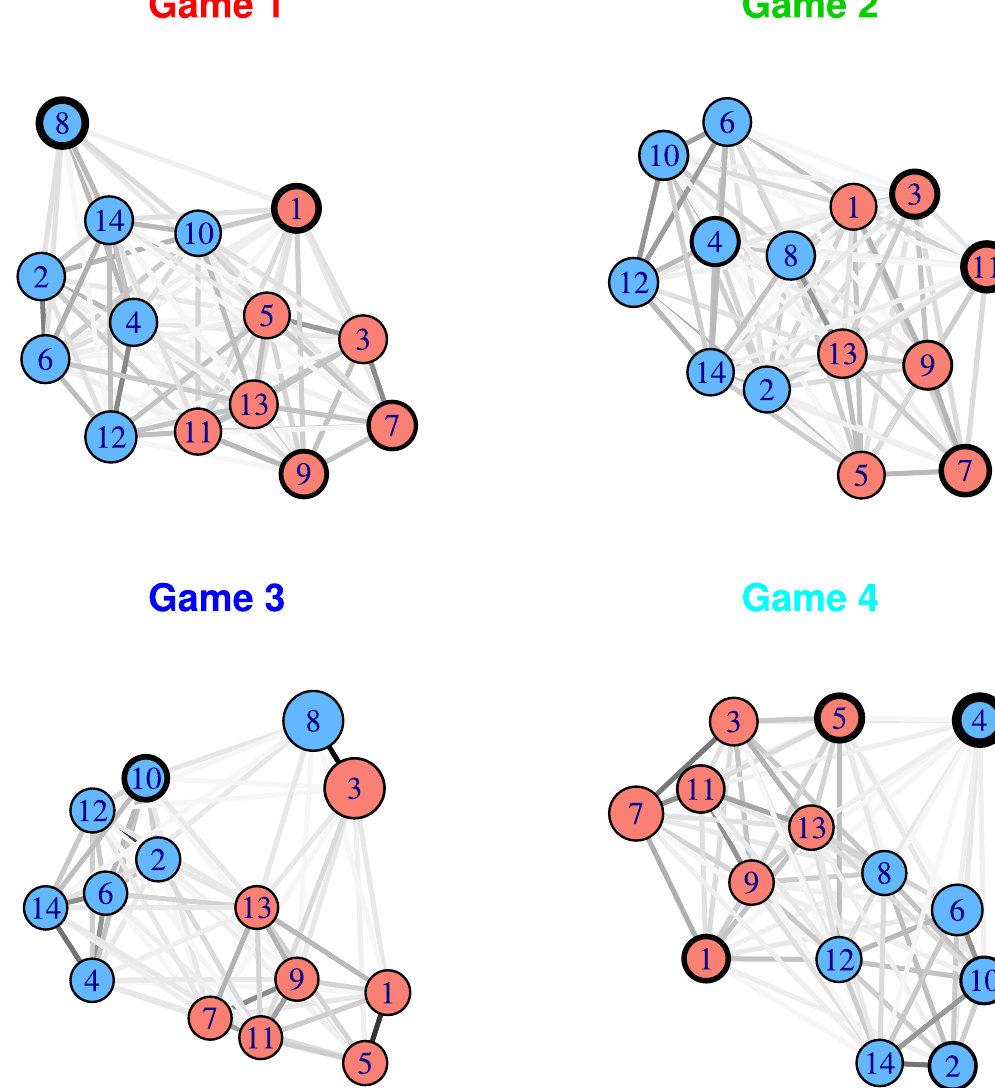
Figure 10. The network of players for each game. The node colour indicates the group while the node size relates to size of the influence scores from Table 4 (larger nodes indicate higher scores). Edges between nodes are drawn if players exchanged tokens, where the edge colour corresponds to the total number of exchanges between the players in either direction (darker edges correspond to more exchanges). The size of the border around a node indicates the level of self-giving for that